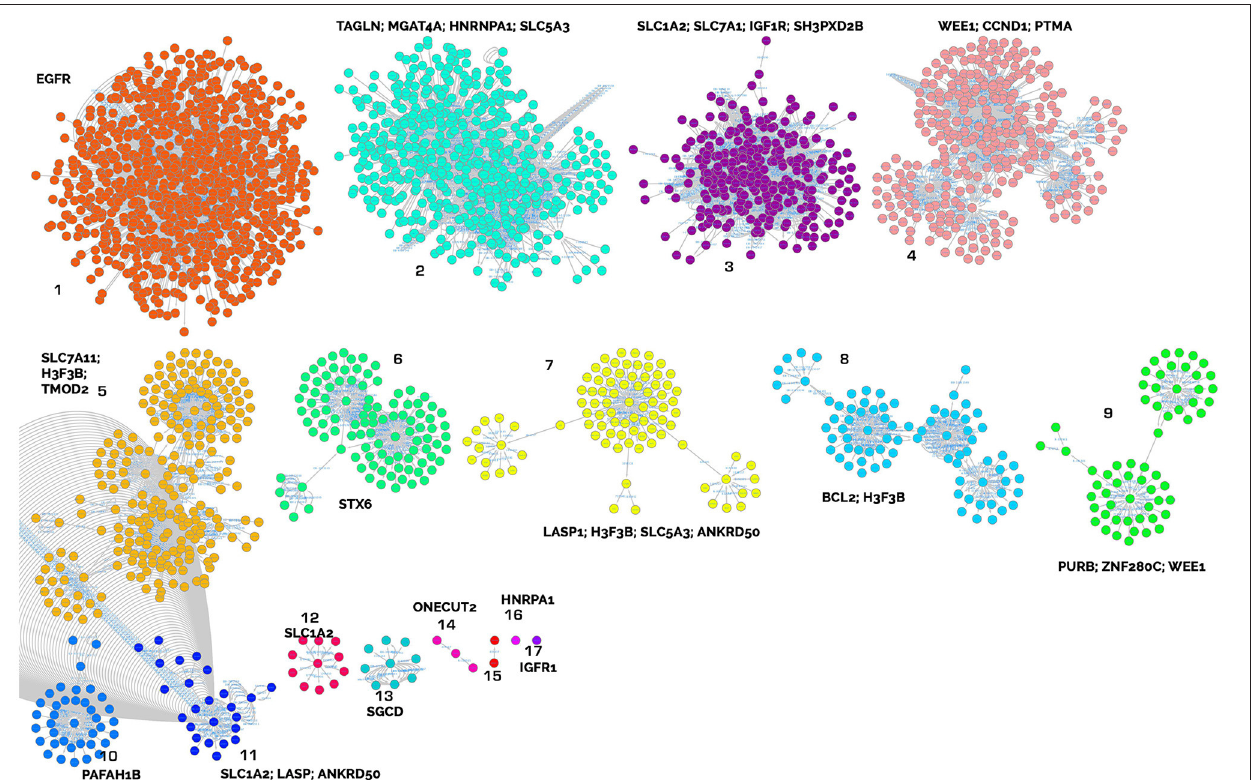
FIGURE 3 | Clusters of proteins from the target analysis of up-regulated miRNAs. Each cluster is named with the central node protein name, targeted from the highest number of miRNAs.